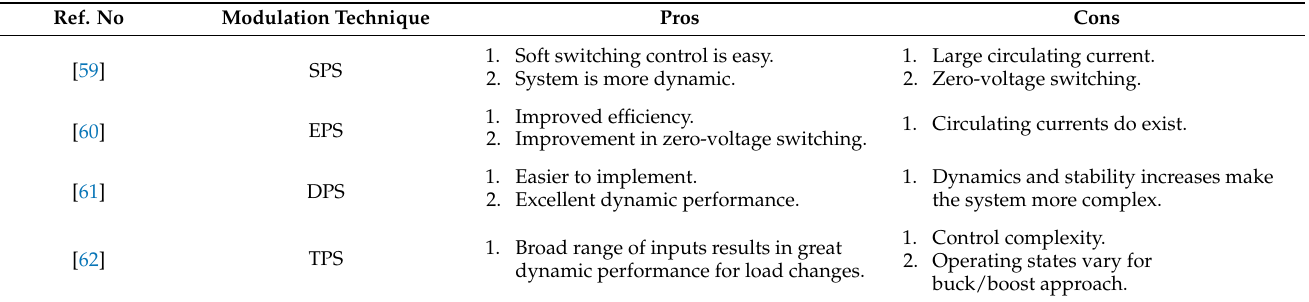
Table 4. Phase-shift modulation strategies